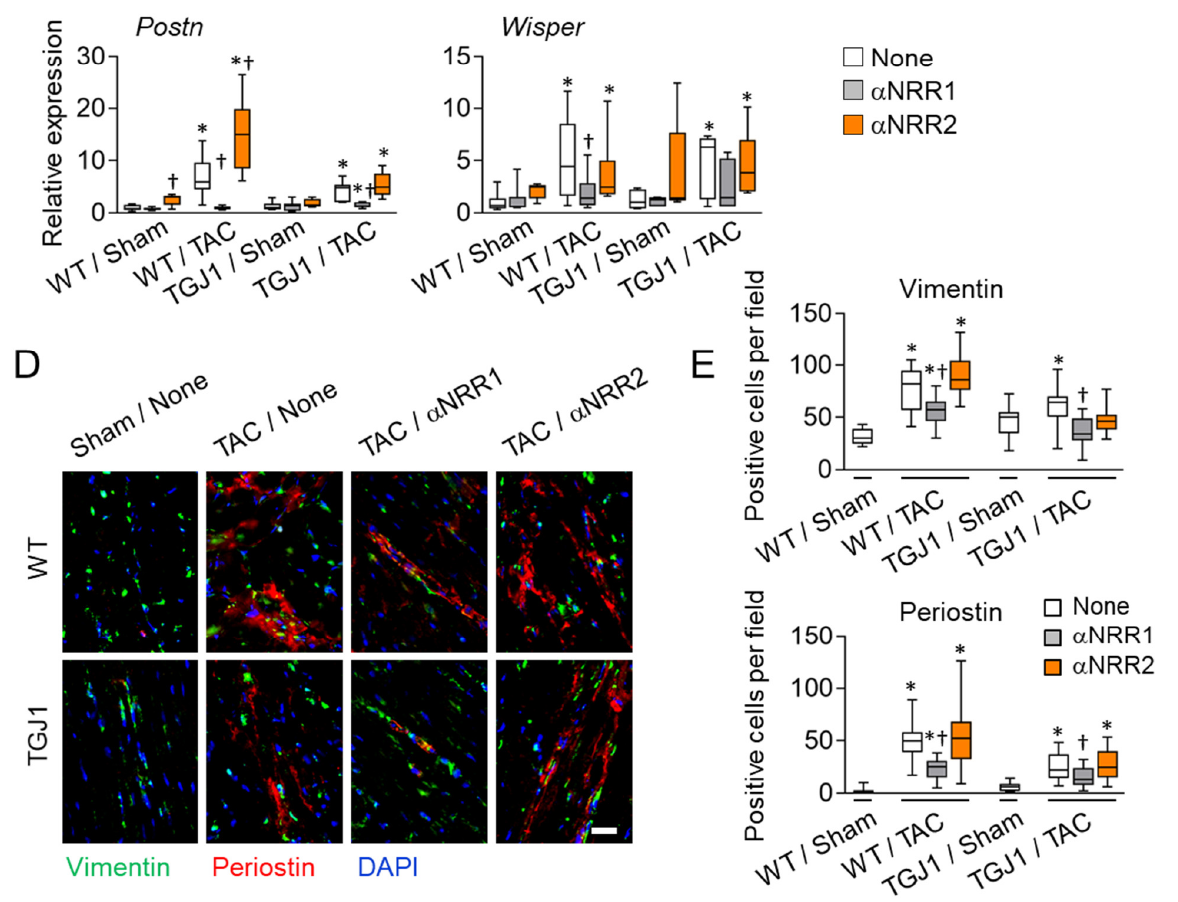
Figure 2. NOTCH1 and NOTCH2 antibody blockade exerts different effects on cardiac fibrosis. ( A ) Mice were operated as in Figure 1, and transverse heart tissue sections were subjected to histo- logical Masson Trichrome staining to reveal collagen deposition (blue). Asterisks indicate the left ventricle cavity. ( B ) Interstitial fibrosis was measured on heart tissue sections stained as in ( A ) and expressed as percent of total heart section area. ( C ) RT-PCR analysis of expression of fibrosis marker genes Ctgf, Tgf- β 2, Col3a1, Postn and Wisper in control WT and TGJ1 mice subjected to sham or TAC operation with α NRR1 or α NRR2 antibody or without antibody treatment (None). Expression levels are relative to untreated, Sham-operated group. ( D , E ) Immunofluorescence staining of heart tissue sections using anti-vimentin (green) and anti-periostin (red) antibodies. n = 5–10 animals/group (see Supplementary Table S2). *, p < 0.05 in TAC vs. Sham; †, p < 0.05 in α NRR vs. None; ‡, p < 0.05 in TGJ1 vs. WT. Scale bar in B = 200 µ m, in ( D ) = 20 µ